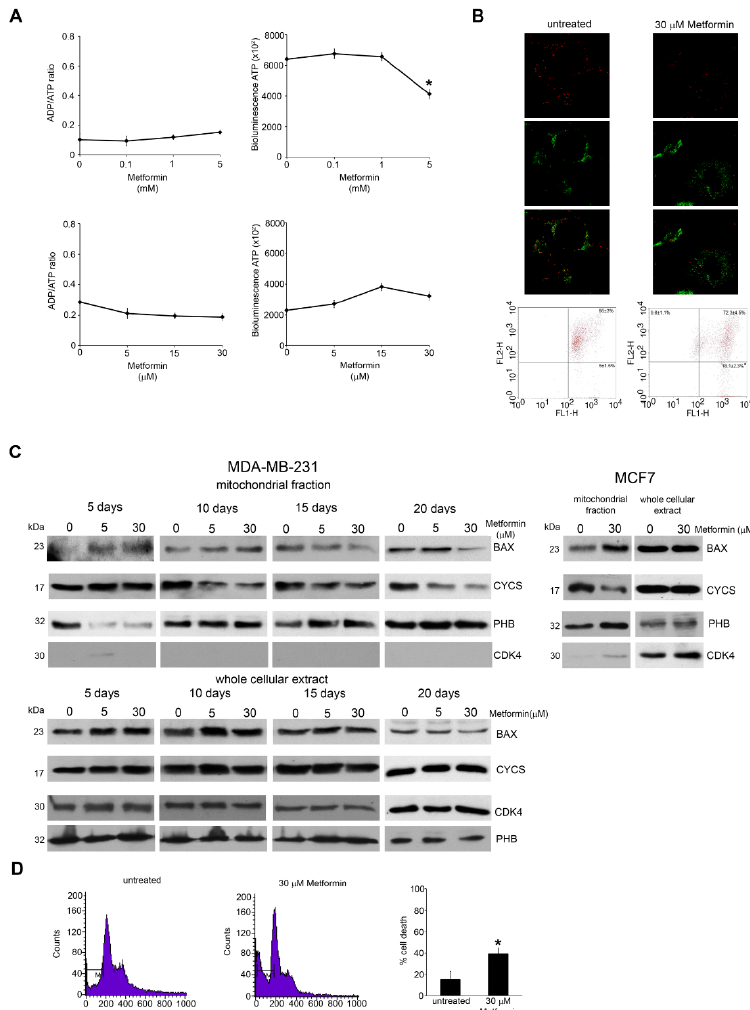
Figure 2. Metformin activates apoptotic cell death; ( A ) MDA-MB-231 cells were plated in 96 well plate and then either left untreated or treated with millimolar (upper graphs) or micromolar (lower graphs) doses of metformin. ADP/ATP ratio was determined as indicated in Material and Methods; ( B ) MDA-MB-231 cells were seeded on glass coverslip and then left untreated or treated with 30 μM metformin. At the end of the treatment, cells were stained with 10 μg/mL JC-1 as indicated under Material and Methods. Mitochondria fluorescence was observed by confocal microscopy. First row: Red fluorescence representing JC1 aggregates. Second row: Green fluorescence representing JC1 monomers. Third row: Merging of the first two rows. Alternatively, cells were treated with 30 μM metformin and stained with JC-1 as above. Red (FL2H) and green (FL1H) fluorescence intensity was quantified by Flow Cytometry; ( C )upper panel: MDA-MB-231 cells were kept in the presence or absence of metformin for the time indicated and then processed to obtain mitochondrial fractions.